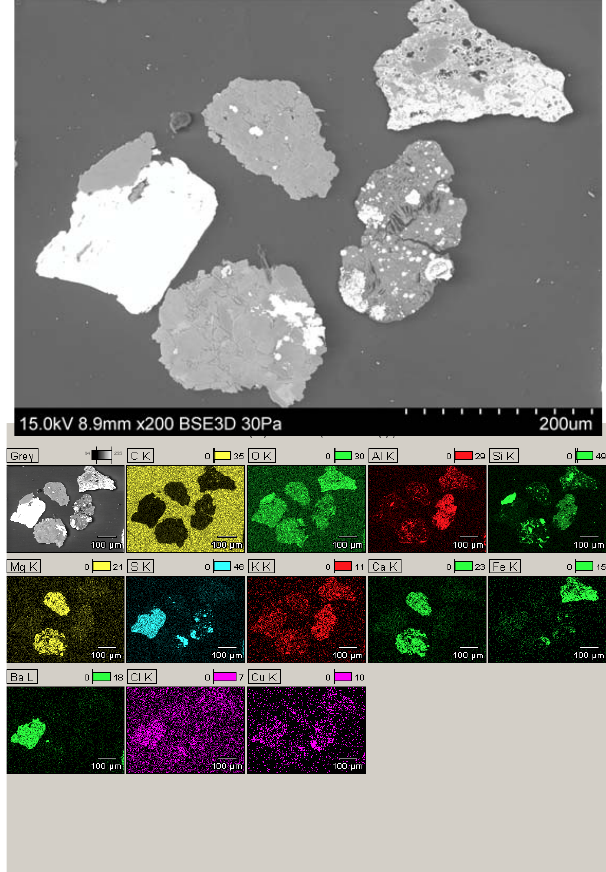
Figure 6. SEM–EDS analysis of heavy fraction of ZM. (upper part of Figure) BSE of sediments indicates mineralogical variable content; (lower part of Figure) metal diversity of the grains in the components of silica (SiO 2 ), K-feldspars, dolomite, clay minerals and barite, the grains indicate oxidizing processes, with a relatively high content of oxide and small quantities of copper sulphides.